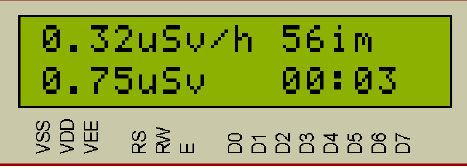
Figure 9. Simulation of the system operation in dosimeter mode.